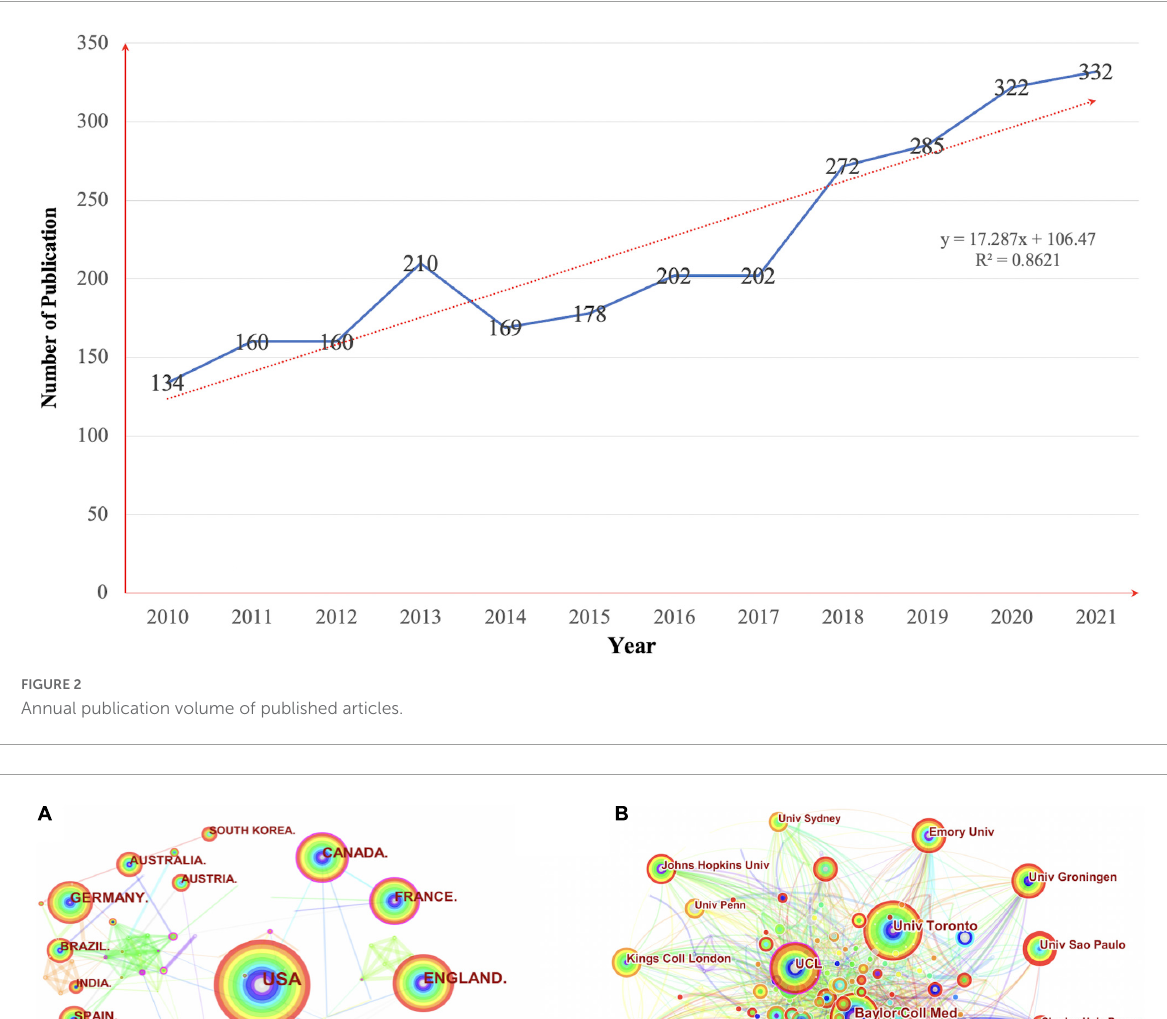
FIGURE3 Map of collaborative relationships between countries (A) and institutions (B) that have published articles. PEOPLES R CHINA, People’s Republic of China; Univ,